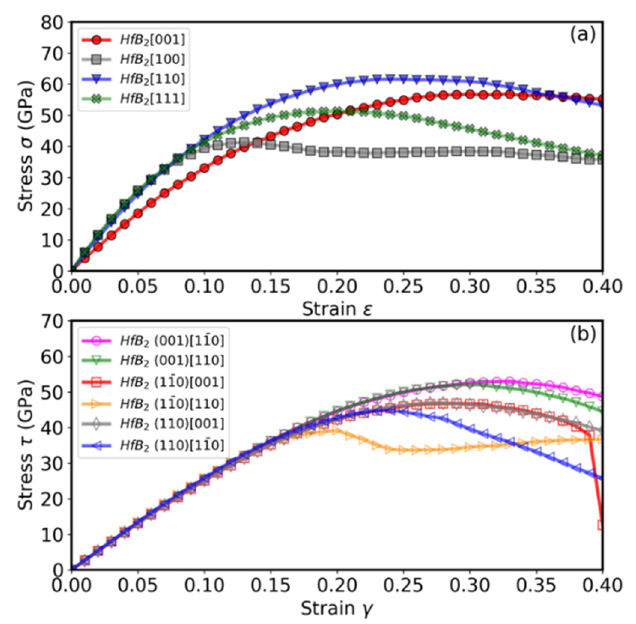
Figure 6. Theoretical stress-strain curves of HfB 2 under ( a ) tensile deformation, and ( b ) shear deformation, up to strain value of 0.4 with a strain step of 0.1 along various directions.